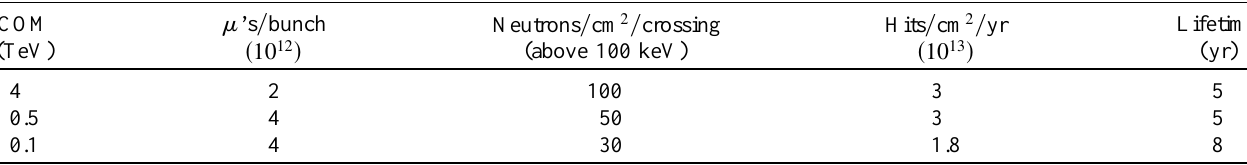
TABLE XVI. Radiation damage by neutrons on silicon detectors. The working assumptions are 1000 turns, 15 Hz and 1 yr (cid:1) 10 7 s. An acceptable number of hits per year is 1.5 3 10 14